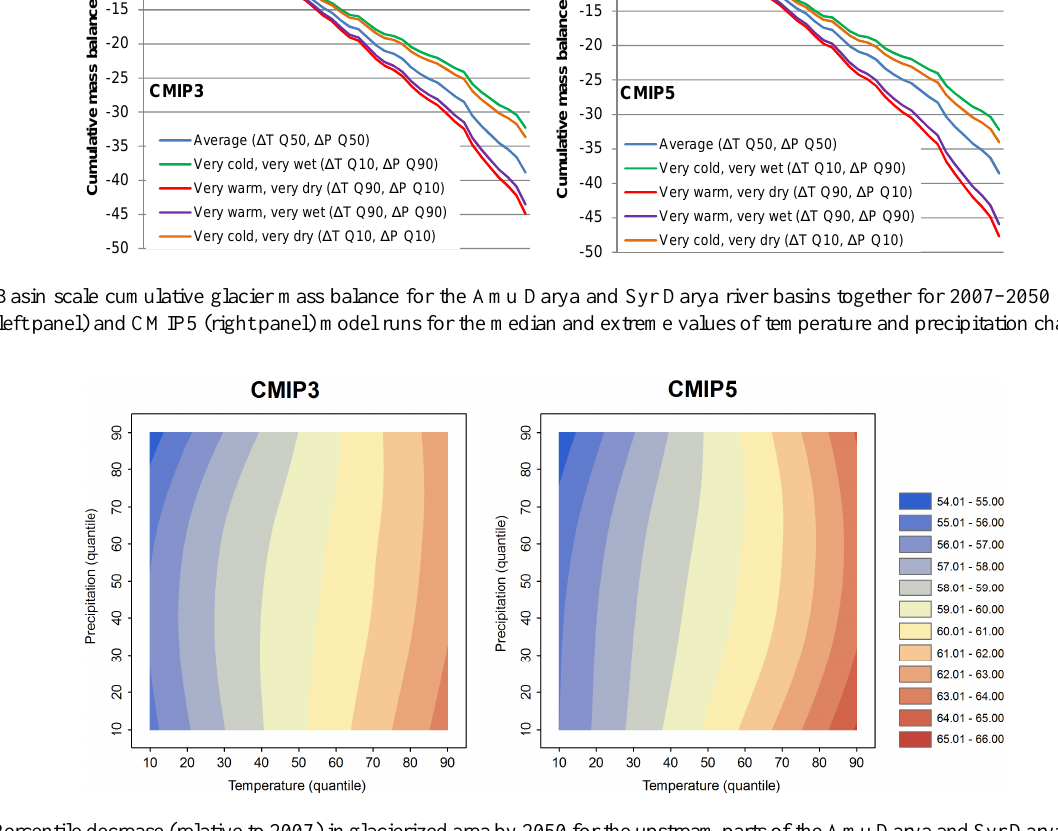
Fig. 12. Percentile decrease (relative to 2007) in glacierized area by 2050 for the upstream parts of the Amu Darya and Syr Darya river basins Figure 12. Percentual decrease (relative to 2007) in glacierized area by 2050 for the upstream 2 together for the changes in temperature and precipitation for CMIP3 runs (left) and CMIP5 runs parts of the Amu Darya and Syr Darya river basins together for the changes in temperature 3 and precipitation for CMIP3 runs (left) and CMIP5 runs (right). 4